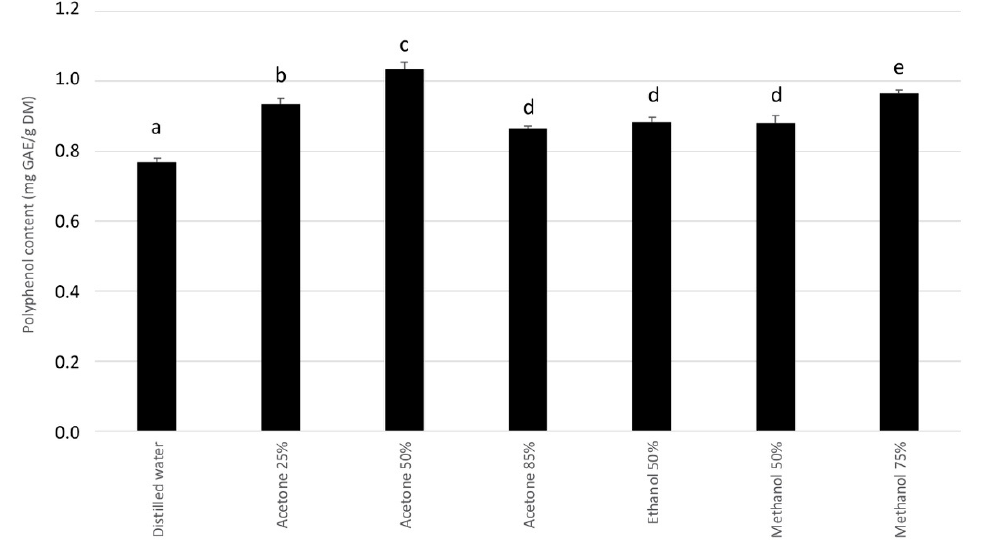
Figure 1. Total polyphenol content from mate as a function of the solvent mixture used. The total phenolic content of mate extracts was determined by using the Folin–Ciocalteu method. The results are expressed in gallic acid equivalent (GAE) and given as the mean +/ − standard deviation (SD) of three experiments. The different letters labeling the histogram bars indicate significant differences between the solvents used for extraction ( p -value < 0.05).